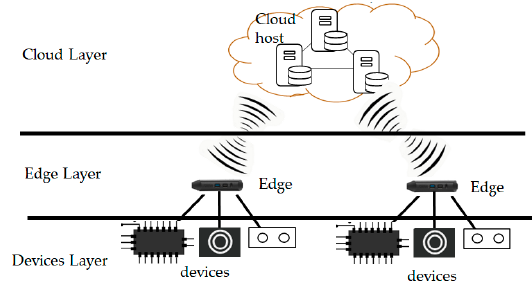
Figure 2. Edge–cloud